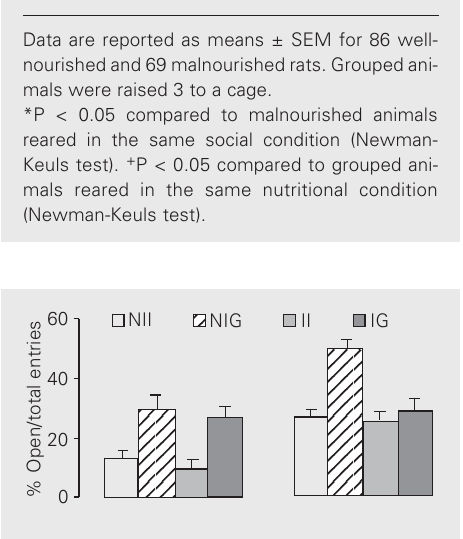
Figure 1. Number of entries (top) and duration of time spent (bot- tom) in the open arms of the elevated plus-maze by non-im- mobilized animals reared indi- vidually (NII) or in groups (NIG) and immobilized animals reared individually (II) or in groups (IG). Data are reported as mean ± SEM percent of total number of entries or of total time for 17-57 rats in each group. *P < 0.05 compared to IG in the same nu- tritional condition (Newman- Keuls